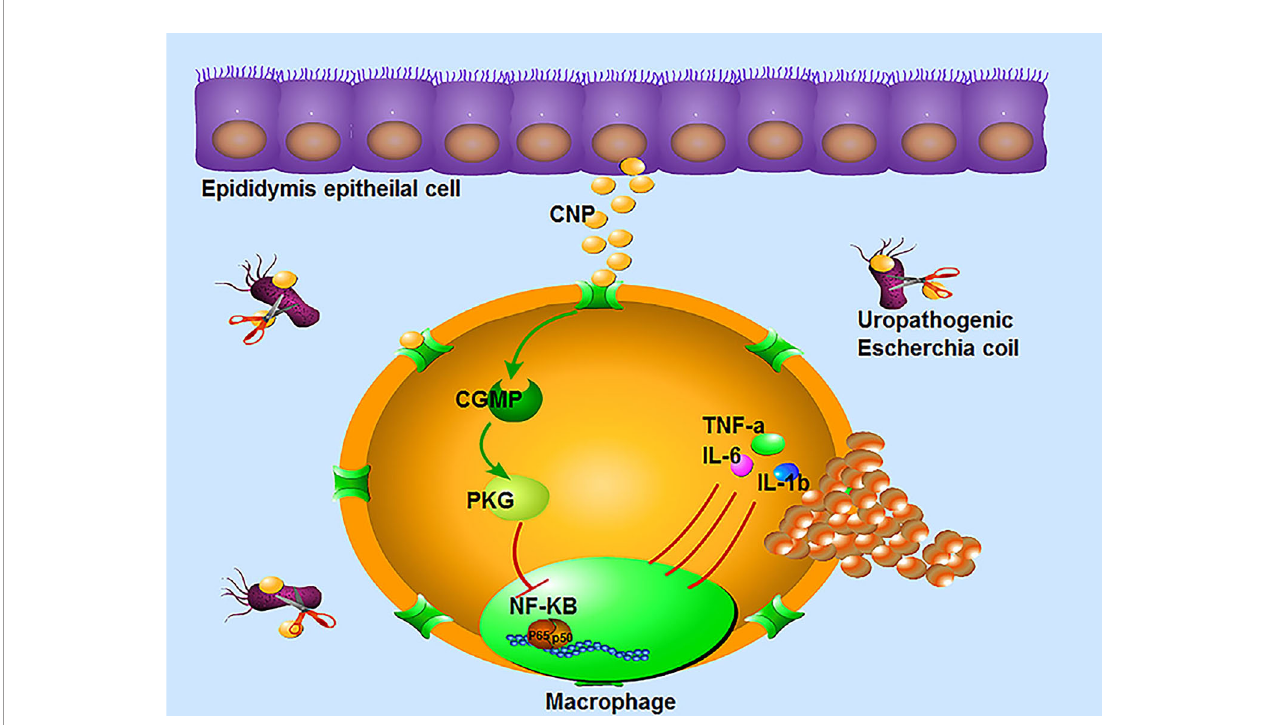
FIGURE 6 | The immunomodulatory mechanism of CNP in epididymitis: ① CNP plays an antibacterial role by inhibiting the proliferation and activity of UPEC . ② CNP not only represses the in fi ltration, proliferation of macrophages, but also downregulates the secretion of pro-in fl ammatory factors by the cGMP-PKG-NF-kB signaling pathway in